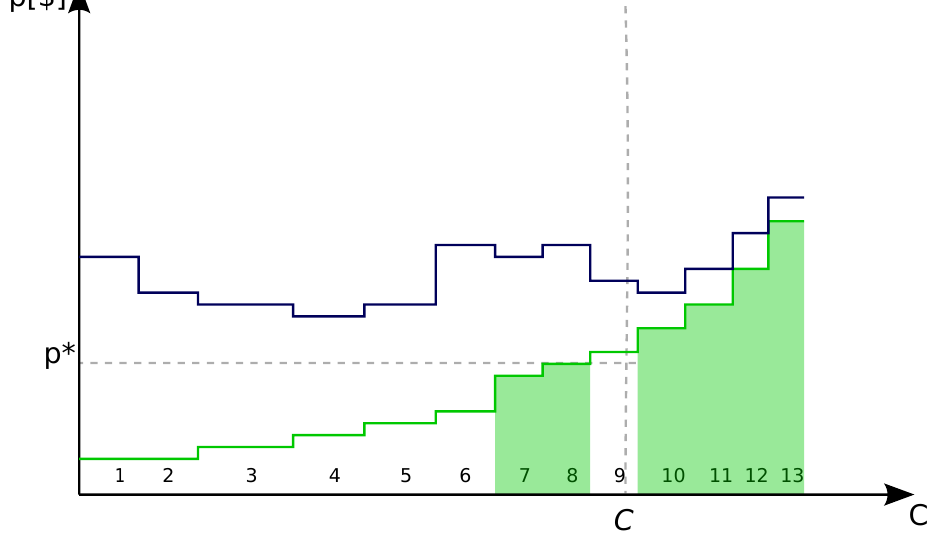
Figure 3. Example for a merit order of capacity (lower graph) with respective adjusted price markups (upper graph) for 13 exemplary power plants identifiable by the respective number n = 1, . . . ,13 and ordered by increasing price bids (step